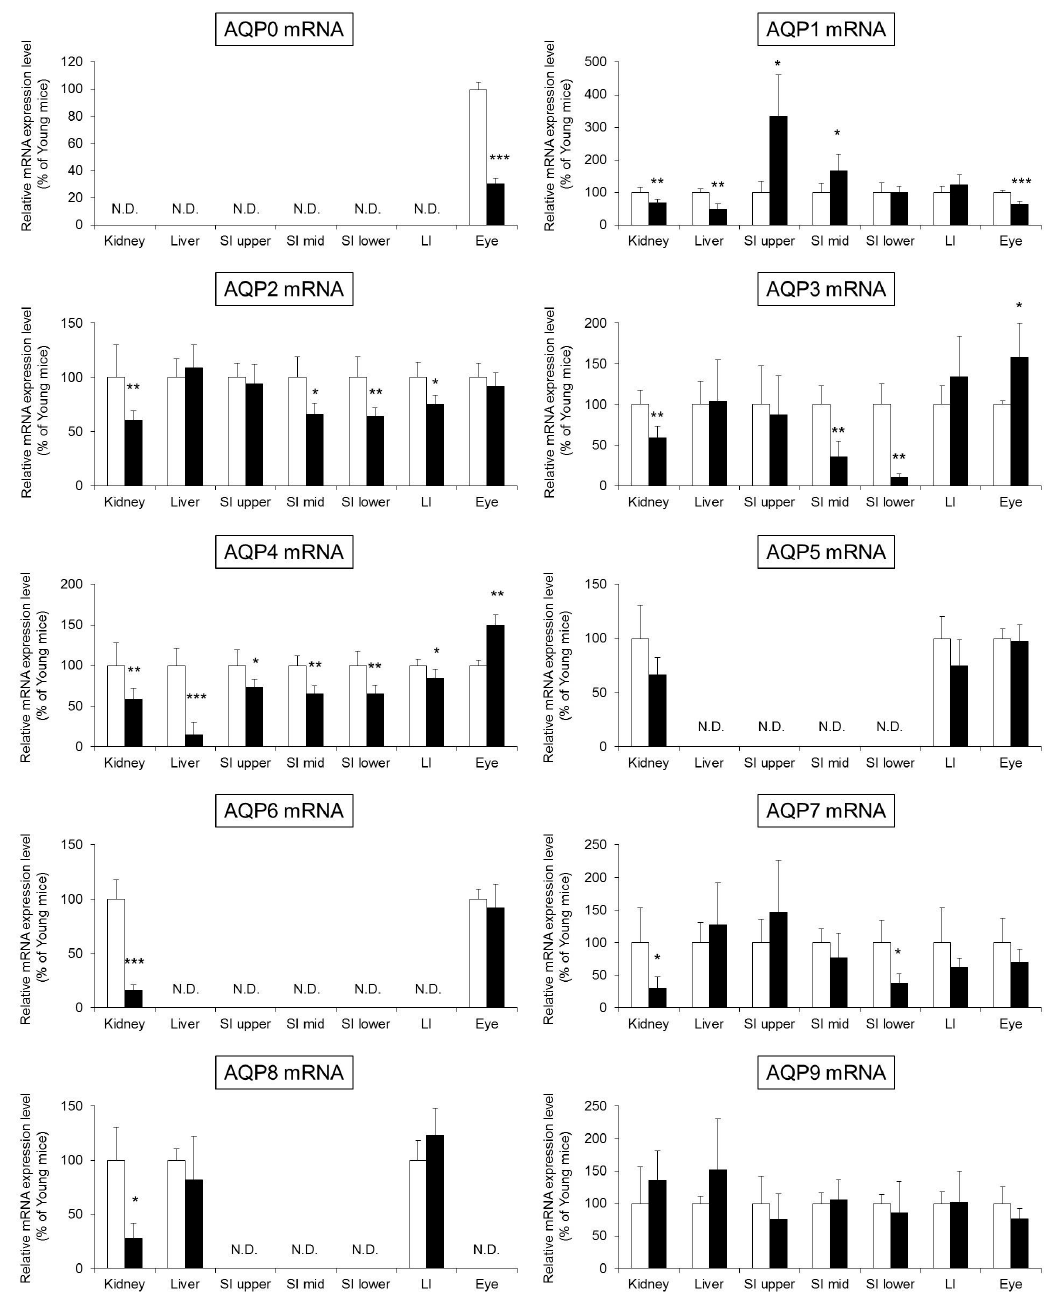
Figure 4. The expression level of AQPs in the whole body. The kidney, liver, small intestine (SI), large intestine (LI), and eye were harvested from young (white) and aged mice (black). The mRNA expression level of AQPs were measured using real-time RT-PCR and normalized to β -actin. Mean levels of AQPs mRNA expression of young mice are indicated as 100%. The data represent the means ± SDs for five mice. Student’s t -test: * p < 0.05, ** p < 0.01, and *** p < 0.001 vs. Young mice. N.D.: Not detect.